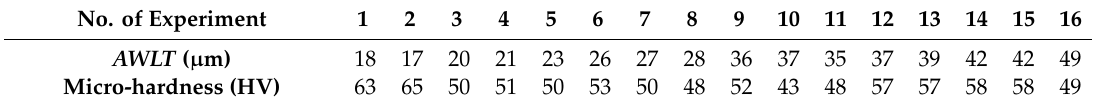
Table 4. Average white layer thickness and micro-hardness of the heat affected zone.